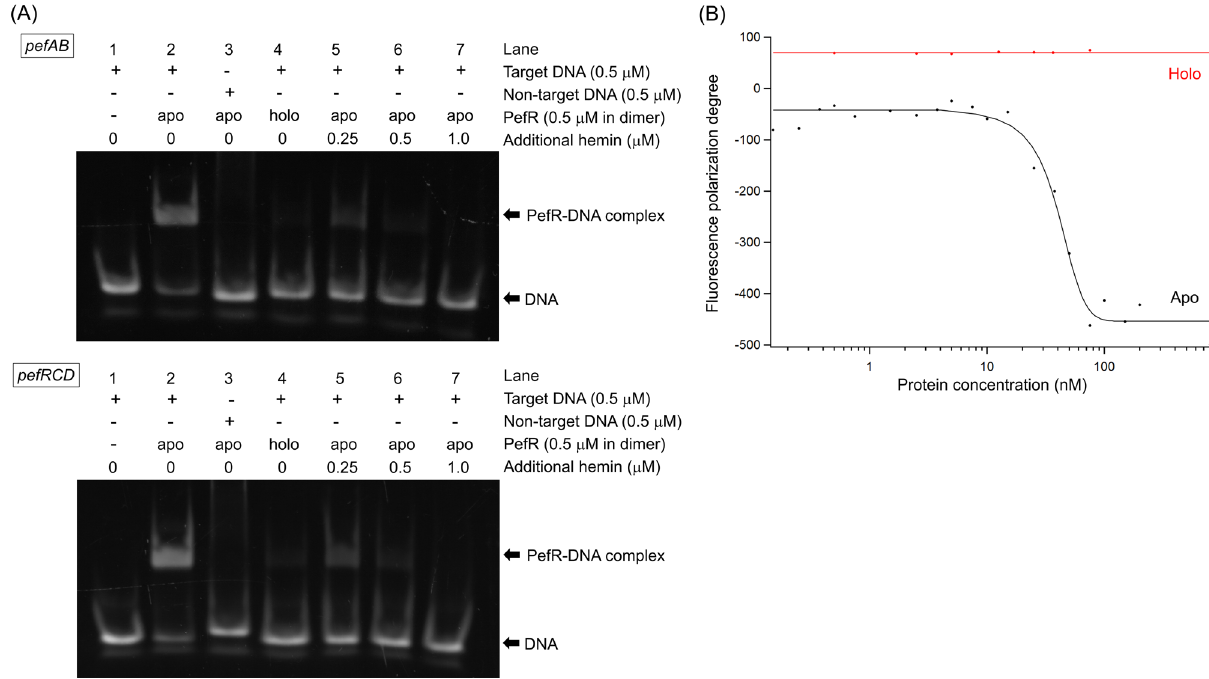
Fig. 1 DNA-binding properties of PefR. A EMSA assays of DNA binding with/without hemin addition. The target DNAs were designed for the pefAB (top panel) and pefRCD (bottom panel) operons. The samples were prepared by mixing PefR protein with double-stranded DNA solution [20 mM Tris-HCl (pH 7.4), 50 mM KCl, 5% glycerol, and 0.2 M MgCl 2 ], after which hemin was added to the mixture (lanes 5 – 7). B Fluorescence polarization assays with apo- PefR (black) and holo-PefR (red). The black line for apo-PefR is the calculated curve, giving a K d of 40 nM, assuming a 1:1 binding ratio of the complex of apo-PefR dimer and one double-stranded